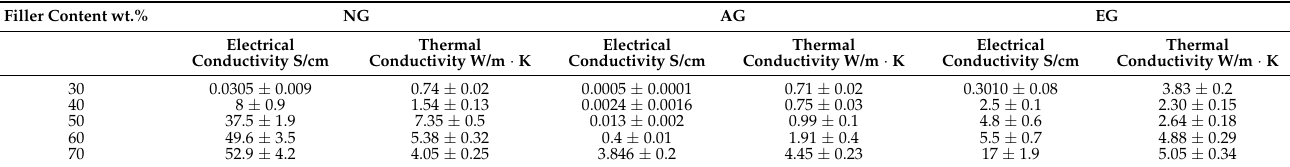
Table 5. Comparison between electrical and thermal conductivity of the